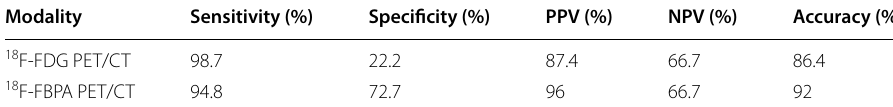
Table 2 Diagnostic performance of 18 F-FDG and 18 F-FBPA PET/CT in target lesions Modality